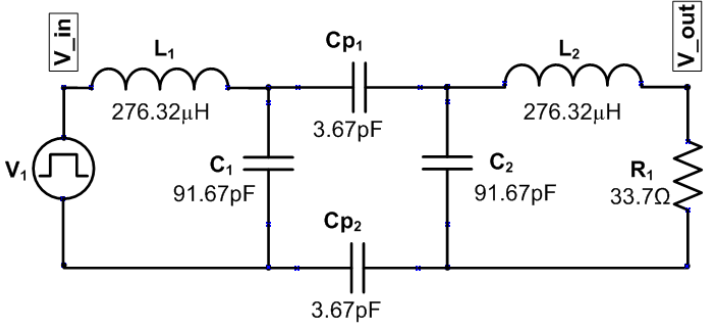
Figure 12. Proposed circuit for frequency simulation. The behavior of G V and G I is shown in Figure 13; it can be noted that the maximum energy transfer takes place at 990.26 kHz, similar to the theoretical expected value. The presence of the multi-resonance phenomenon is also consistent with the theoretical analysis presented in this